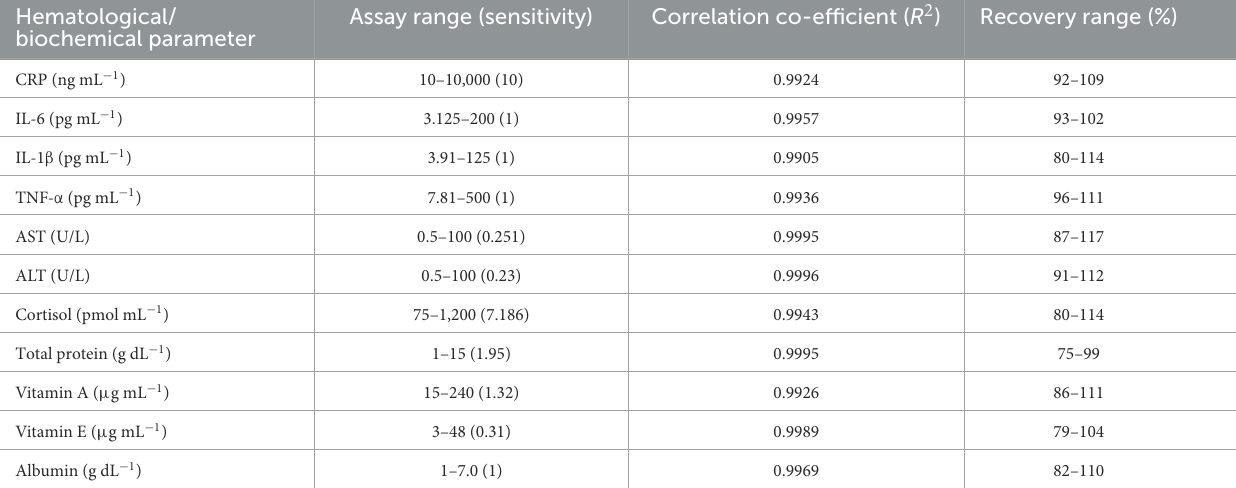
TABLE 1 Performance characteristics of various hematological/ biochemical parameter assay kits. Hematological/ biochemical